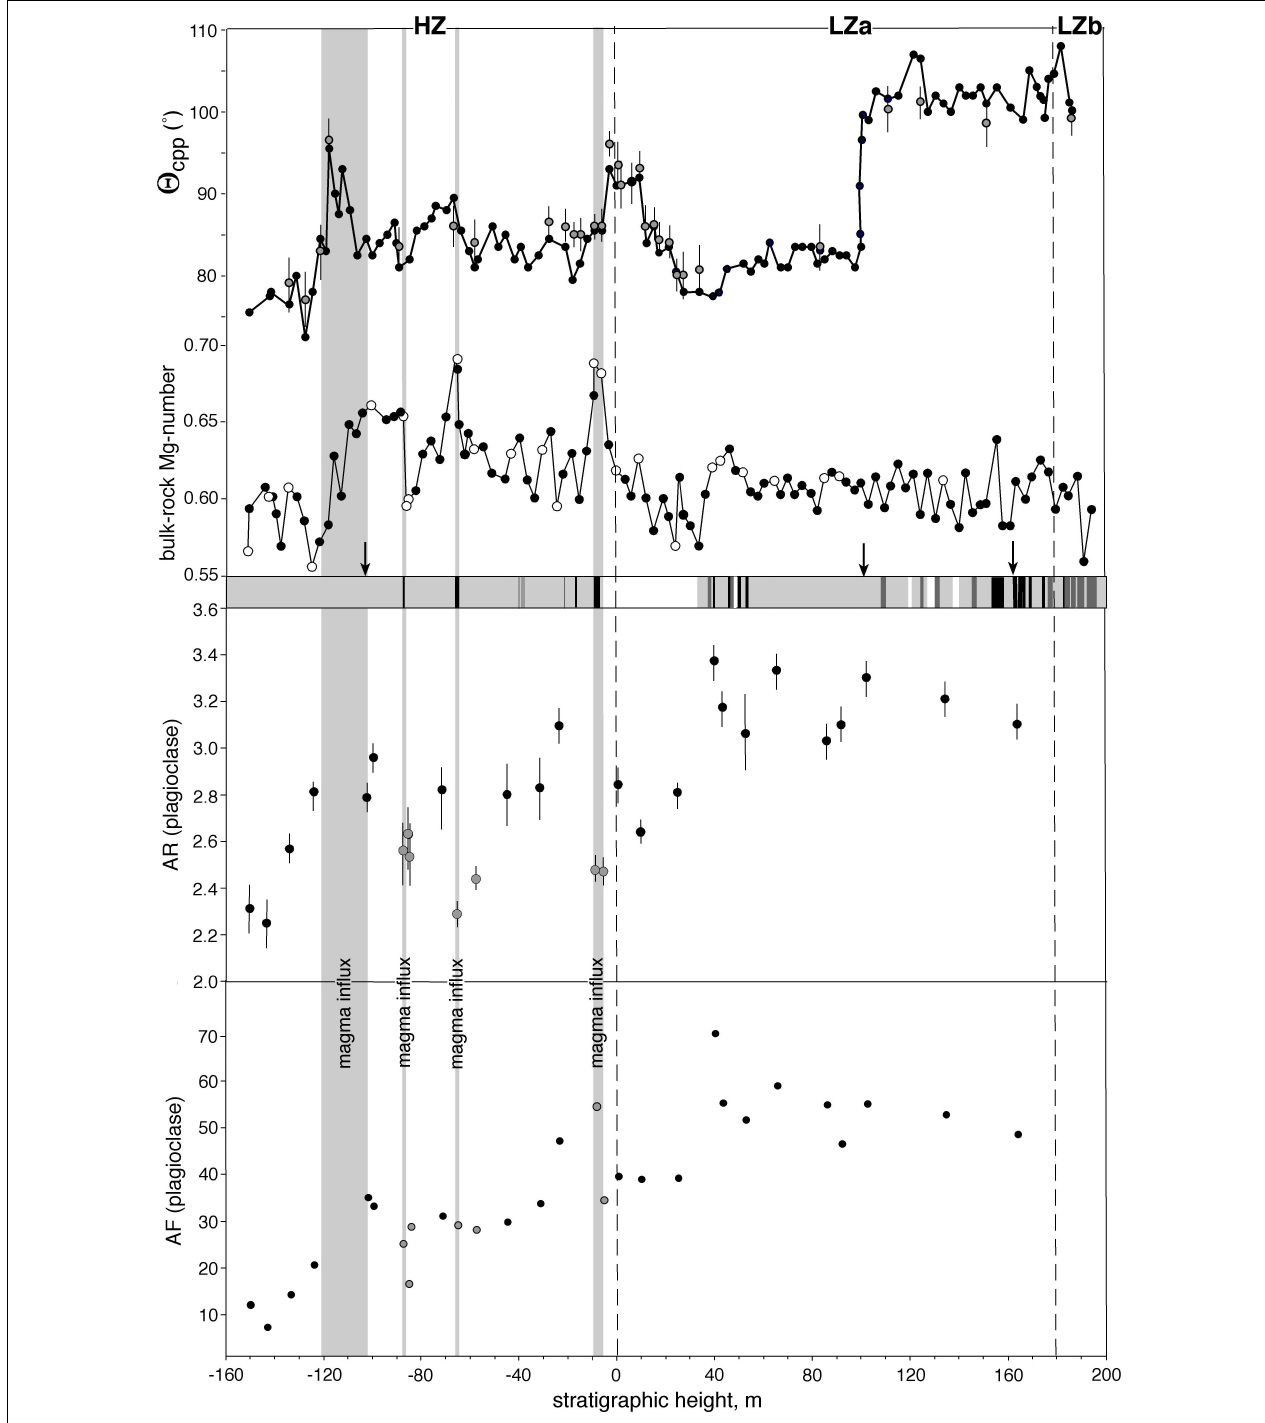
FIGURE 3 | Microstructural and compositional variation through the 1966 Cambridge drill core, sampling the lowest 350 m of the Skaergaard Layered Series. The schematic log shows olivine-rich bands as black, average compositions as gray and leucocratic bands as white [see Holness et al. (2015) for further details]. The stratigraphic variation of clinopyroxene-plagioclase–plagioclase dihedral angle, (cid:50) cpp , and the bulk rock Mg-number are shown [from Holness et al. (2007c, 2015)]. The dotted lines show the divisions into HZ, LZa, and LZb. The vertical gray bands show the regions of stratigraphy identified by Holness et al. (2015) as recording the input of magma into the inflating chamber. Samples described in the present study are shown as open circles in the Mg-number plot if compositional data is available, with the position of the three samples for which no compositional data is available shown as arrows on the schematic log. The variation of plagioclase AF and AR are shown. Those samples denoted by a gray circle are those closely associated with the points marking magma influx and chamber inflation.